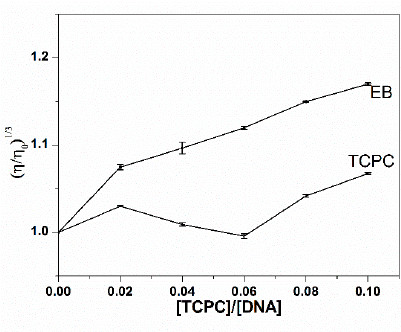
Figure 4. Effect of the addition of TCPC on the relative viscosities of DNA (100 mM) in Buffer I at 30 ± 0.1 °C.